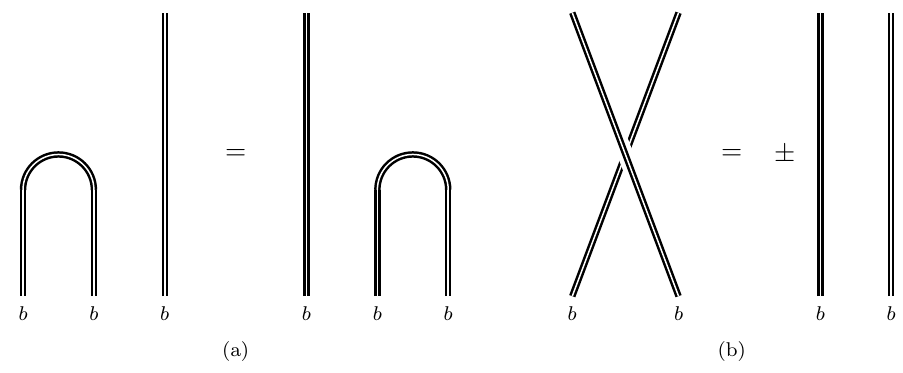
Figure 21 . Z 2 1-form symmetries: (a) There exists a bulk line b with properties shown in the (cid:12)gure. (b) Half-braiding b lines across each other gives a factor of (cid:6) 1 when compared to b lines without braiding. The factor of +1 arises for a bosonic 1-form symmetry and (cid:0) 1 arises for a fermionic 1-form symmetry. This minus sign implies that the symmetry is anomalous.